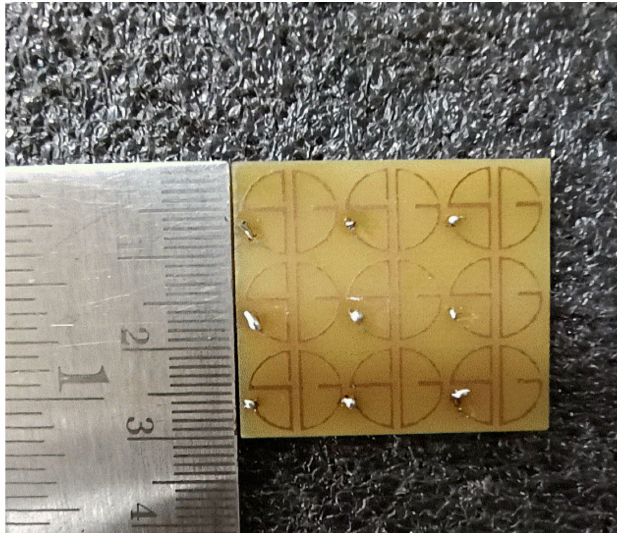
Figure 12. Fabricated 3 × 3-unit cell prototype.